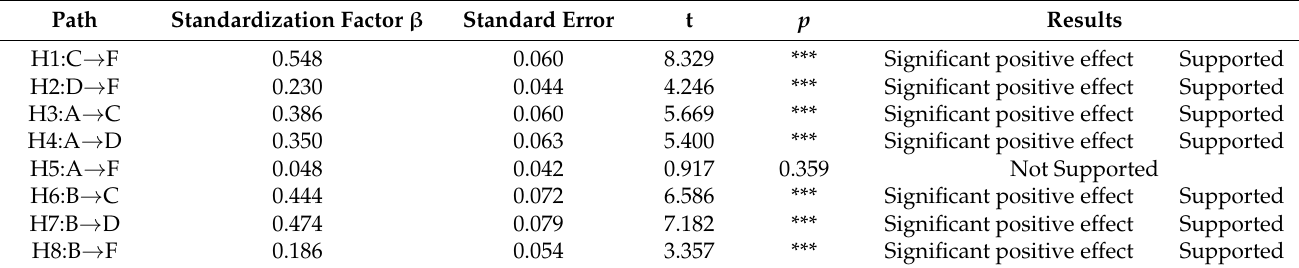
Table 3. Path Testing ( p < 0.001,